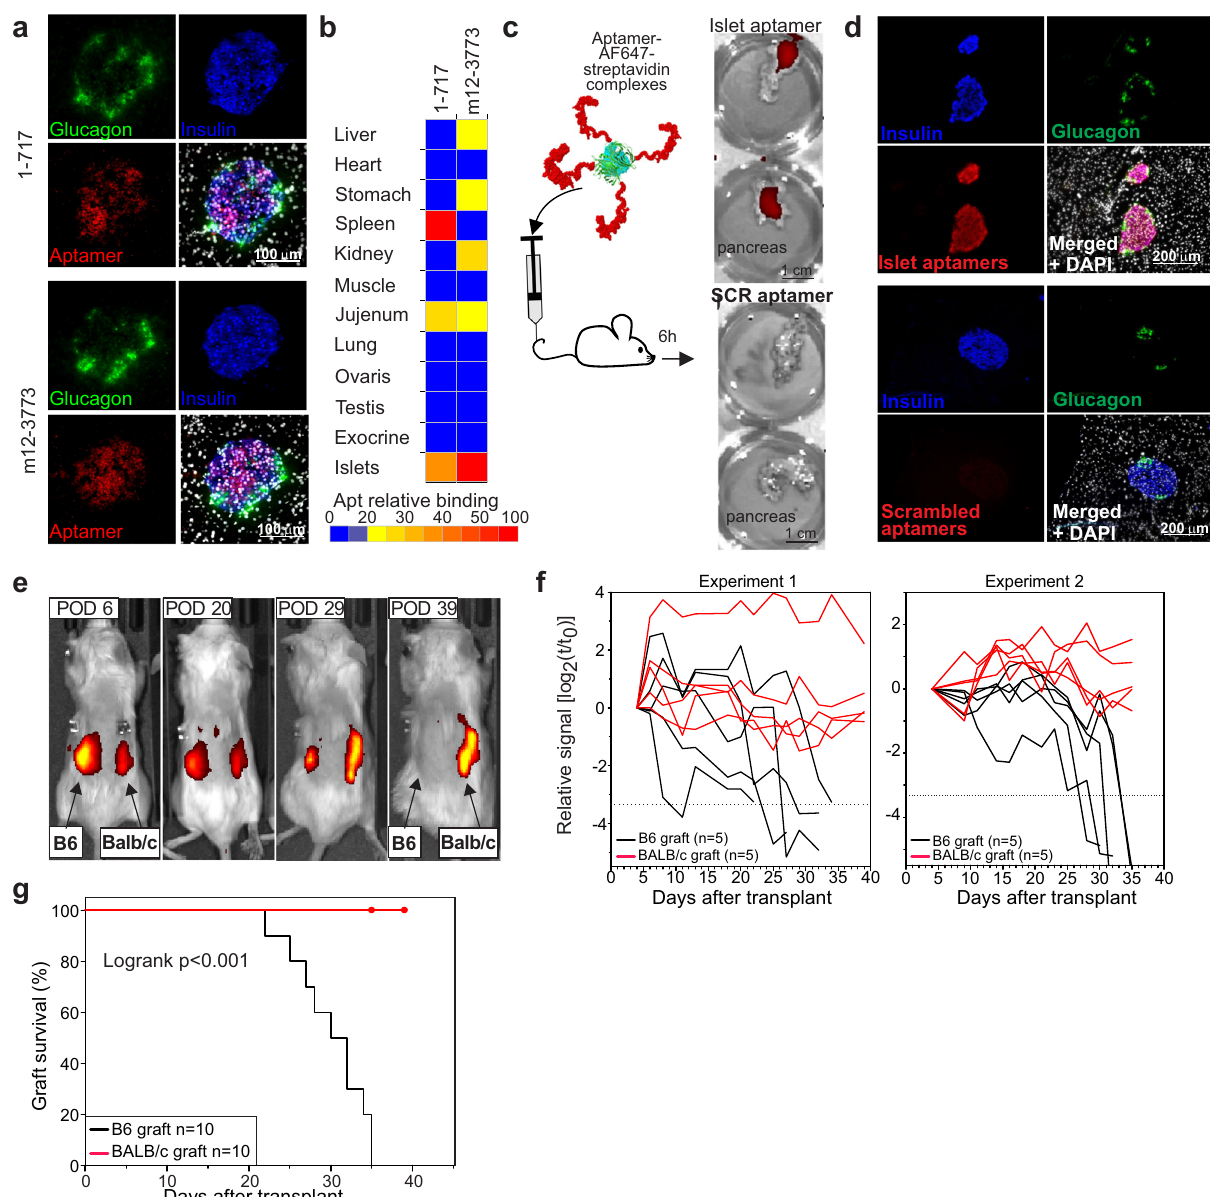
Fig. 6 Aptamers 1-717 and m12-3773 cross-react with mouse islets in vitro and in vivo. a Sections of BALB/c pancreatic tissues stained with aptamers 1-717 and m12-3773 and antibodies against insulin and glucagon were imaged with a confocal microscope. A representative image of two independent experiments is shown. b Mouse tissue arrays were labeled with aptamers 1-717 and m12-3773, images acquired with a fl uorescence microscope, and processed with Cell Pro fi ler c An equimolar mixture of biotinylated aptamers 1-717 and m12-3773 or a mixture of the corresponding scrambled aptamers were conjugated with AF647-conjugated streptavidin and injected i.v. in BALB/c mice. Four hours later, pancreases were removed and analyzed by IVIS. A representative image of two independent experiments is shown. d Pancreases from ( c ) were snapped frozen, sections cut, and counterstained with anti- insulin and anti-glugagon antibodies. Images were taken with a fl uorescence microscope. A representative image of two independent experiments is shown. e BALB/c mice were transplanted s.c. dorsally with allogeneic islets from C57BL/6 mice on the left and islets from syngenic islets on the right. An equimolar mixture of aptamers 1-717 and m12-3773 conjugated to AF750-streptavidin was injected intravenously at different timepoints. Four hours after injection, mice were imaged by IVIS. f Two independent experiments with n = 5 mice each are shown. g Survival curve of syngeneic and allogenic grafts. A graft was considered lost when the fl uorescence signal was similar to the backgrounds (~10 times lower than the initial signal). Data derived from n = 10 mice from two independent experiments. Log-rank test was performed. Source data are provided as a Source Data fi